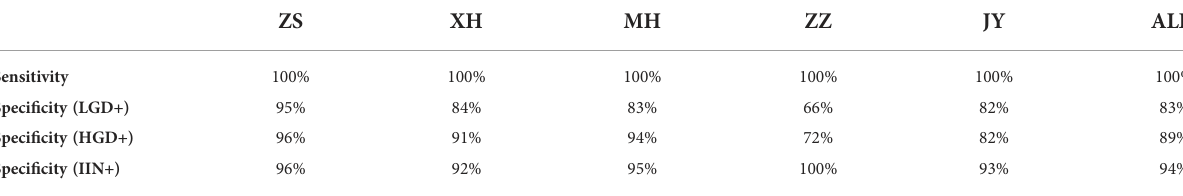
TABLE 2 Sensitivity and speci fi city by category and center on screening for NED.